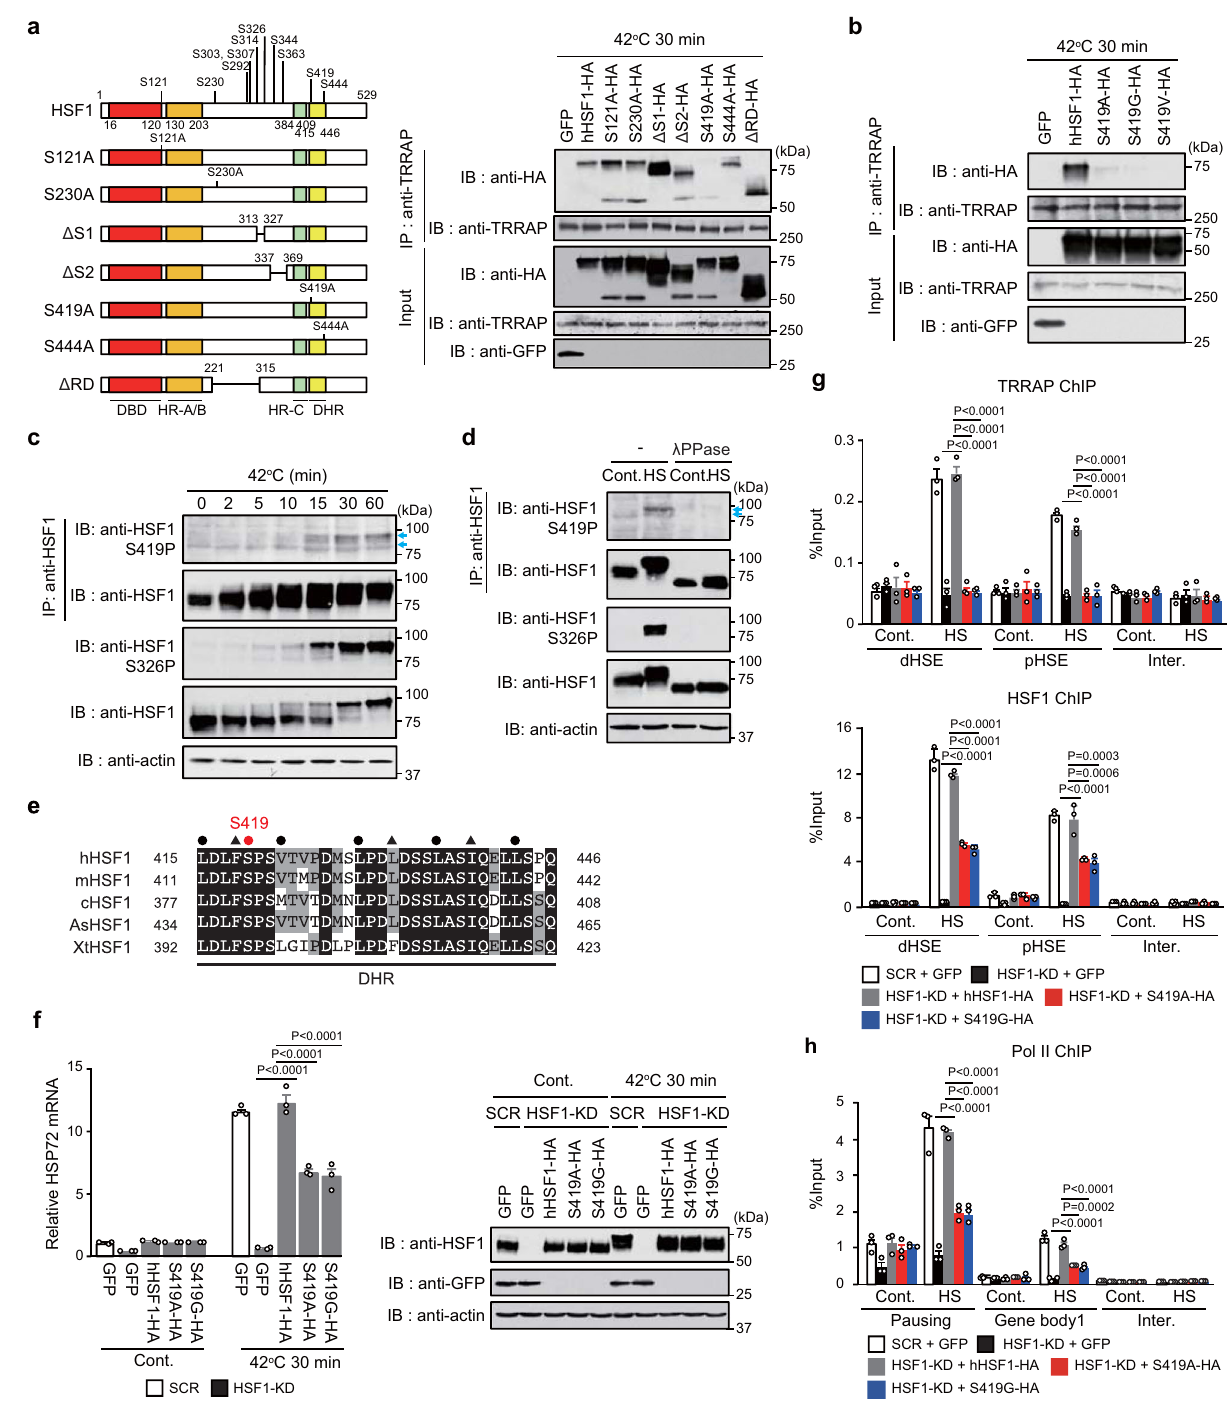
Fig. 2 | Phosphorylated HSF1 at S419 recruits TRRAP to HSP72 promoter. a, b Schematic representation of phosphorylation sites in hHSF1 and its mutants. DBD (red box), DNA-binding domain; HR (orange box), hydrophobic heptad repeat; DHR (light green box), downstream of HR-C (yellow box). Extracts of heat-shocked HSF1-null MEF cells expressing these mutants or GFP were co-immunoprecipitated using anti-TRRAP and subjected to immunoblot- ting.HeLacellsweretreatedwithheatshock,andcellextractsweresubjectedto HSF1 immunoprecipitation and immunoblotting using antibody for HSF1 phospho-S419 or HSF1 ( c ). Some extracts were incubated without ( − ) or with lambda protein phosphatase ( λ PPase) ( d ). Blue arrows indicate the positions of HSF1-S419phosphorylatedbands.Theintensityoftheupperbandwasmarkedly enhanced during heat shock. e Alignment of amino acid sequences for the DHR